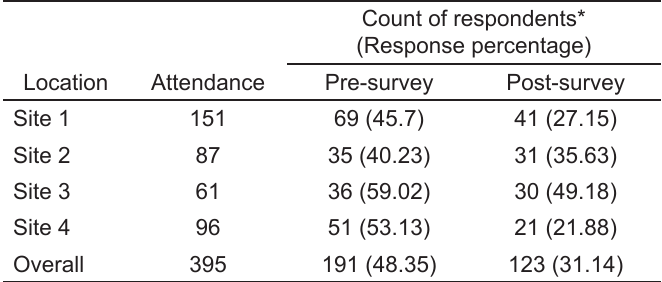
Table 1. Response proportions to surveys administered before and after virtual information sessions across the four study